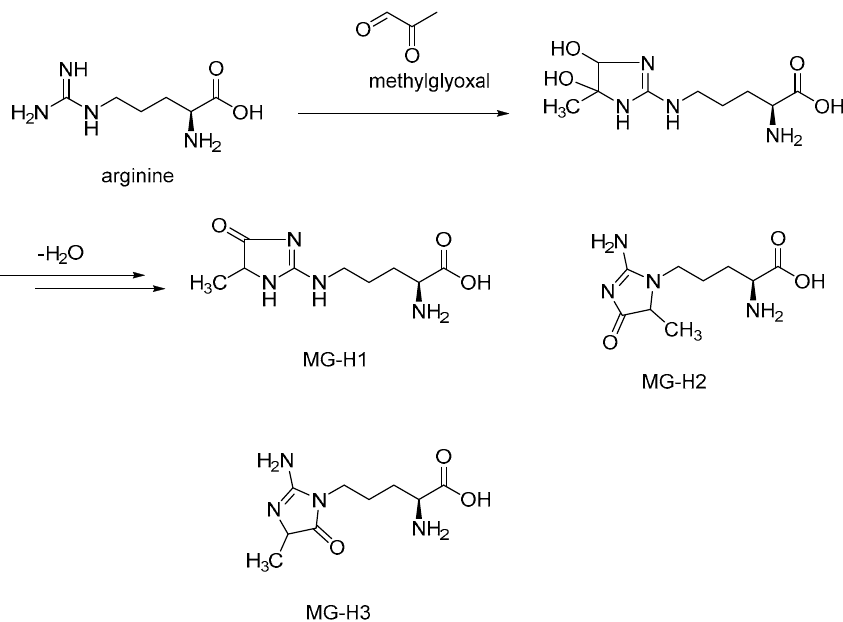
Figure 5. Maillard-reaction-derived AGE products of arginine and methylglyoxal.